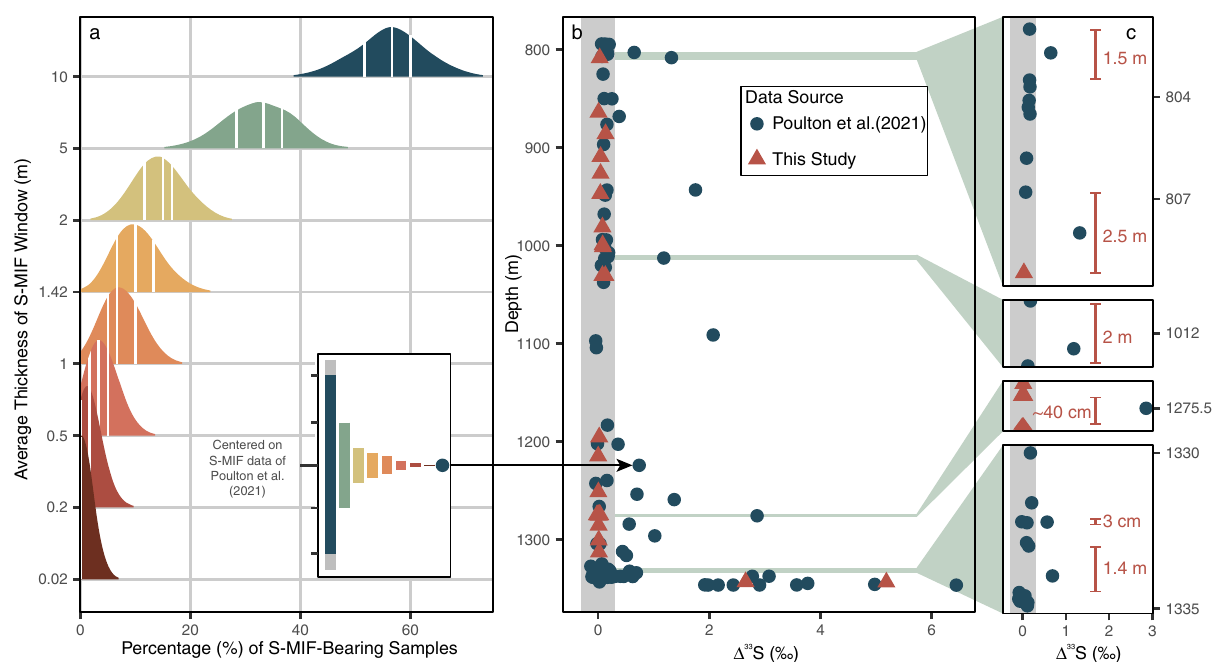
Fig. 5 | Statistical- and data-based constraints on the longevity of post- Rooihoogte-aged S-MIF-bearing intervals. a Colour-coded frequency distribu- tions resulting from 1000 replicate 60-sample bootstrap sampling routines, tar- geting synthetic cores with variably thick mass-independent sulfur isotope fractionation (S-MIF)-bearing windows (y-axis) positioned using the pre-existing EBA-2 Δ 33 S dataset 25 , as exempli fi ed using the sample from 1224.0m core depth (insert;SupplementaryFig.10).Themedianand25 th and75 th quartilesareshownas vertical white lines. b Pre-existing Δ 33 S data from core EBA-2 25 (blue circles), aug- mented with our new quadruplesulfur isotope(QSI) measurements (red triangles),